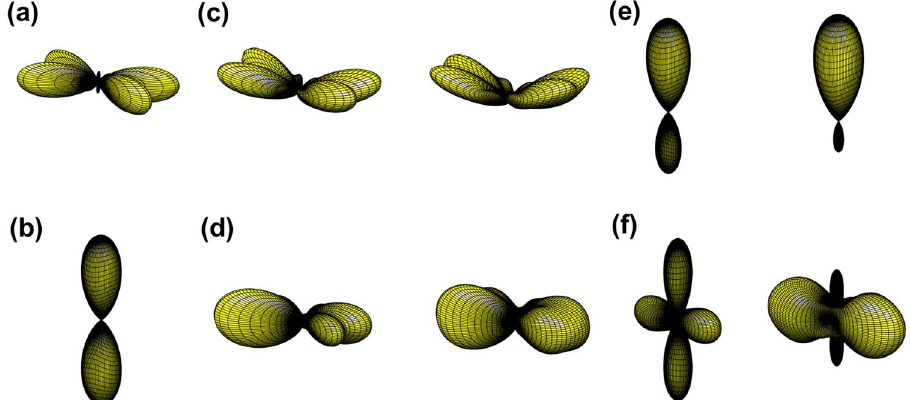
Figure 5. The far-field Ω f ( θ , φ ) of ˆ x -polarized HPI two-photon states for N φ = 8 and N r , z = 1, 2 and 3 in the stacked and concentric rings. For single ring, we plot two subradiant states ( a ) l = 2 and ( b ) l = 4 for comparisons. For stacked rings, the subradiant states with ( c ) l = 2 and ( e ) l = 4 are illustrated with N z = 2 and 3 from left to right. Similarly for concentric rings, the subradiant (left) and superradiant (right) states respectively with ( d ) l = 2 and ( f ) l = 4 are illustrated with N r = 2 and 3 from left to right. The viewing angle and other parameters are the same as in Fig. 2(a), and stacked ring separation d z / λ = 0.35, concentric inter-ring distance d r / λ = 0.2.